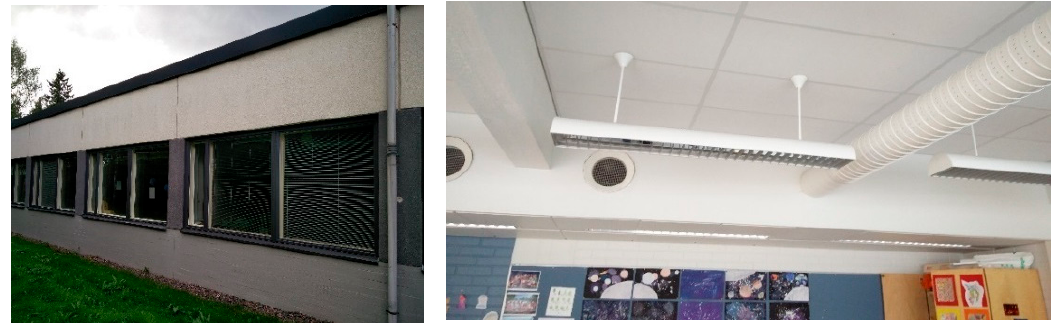
Figure 1. Studied building section, a typical supply air duct diffuser, and an extract air grille in a classroom.